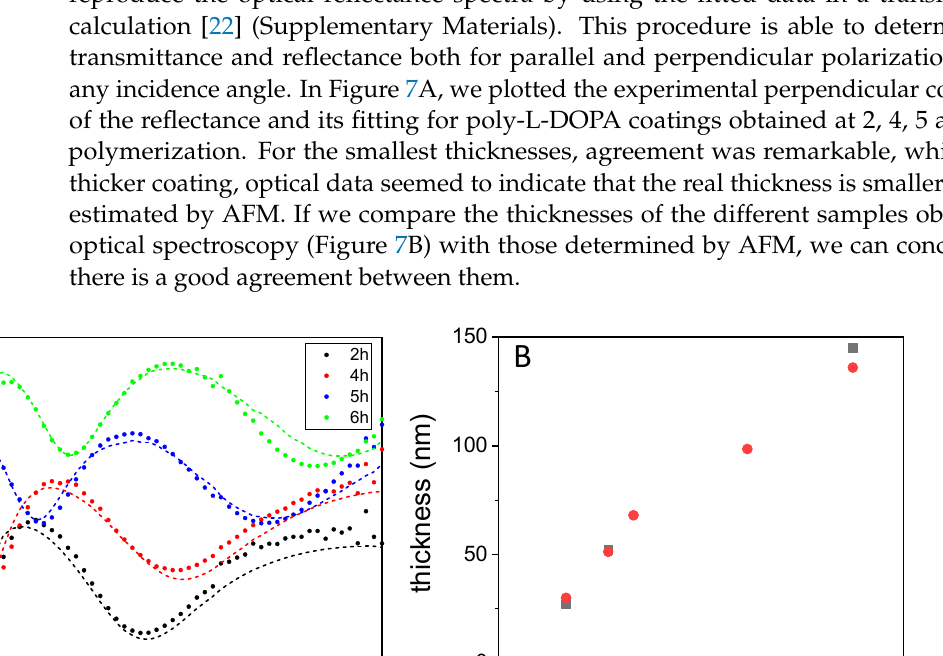
Figure 8. Absorbance spectra (line) and simulated spectra (empty circles) of the poly-L-DOPA film (red) and the aggregates of poly-L-DOPA aggregates in water (black). The aggregates of poly-L-DOPA in water presented a broad declining absorbance with the wavelength in the 200–800 nm range without any spectral characteristic in agree- ment with prior works dealing with synthetic melanins [25], but a broad and weak ab- sorption at 280 nm, which could be attributed to the initial precursor (DOPA) of the polymerization, was observed. The spectrum profile resembled the scattering profile, which presented an intensity dependence of λ − 4 . The experimental spectrum was simu- lated taking into account the Mie theory [26,27] by considering a diameter of 50 nm for the aggregates; see Figure 8. On the other hand, in the spectrum of the poly-L-DOPA film, two broad bands could be detected; see Figure S4 (Supplementary Materials): the first, from 290 to 425 nm and centered around 350 nm, and a second broad band above 500 nm. The band between 298 and 425 nm could be attributed to the absorption of 5,6-dihydrox- yindole-2-carboxylic acid (DHICA) and its π -stacked forms [28,29]; DHICA had been